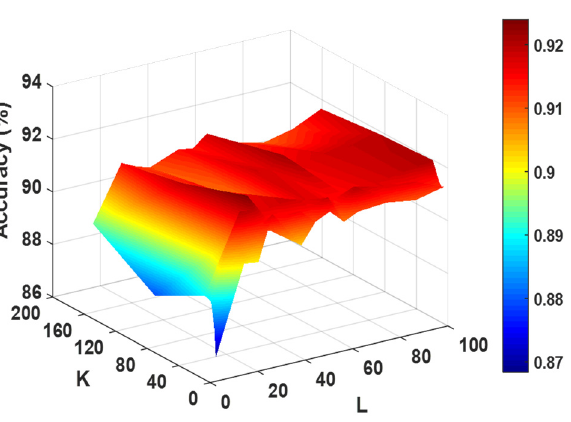
Figure 2. The influence of different parameters of the FwRF classifier on classification accuracy.